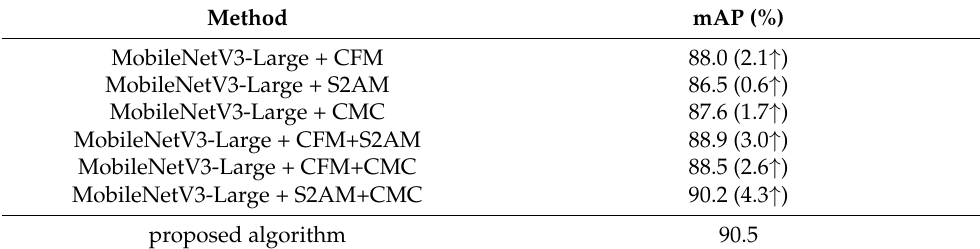
Table 3. Performance evaluation of ablation experiments.